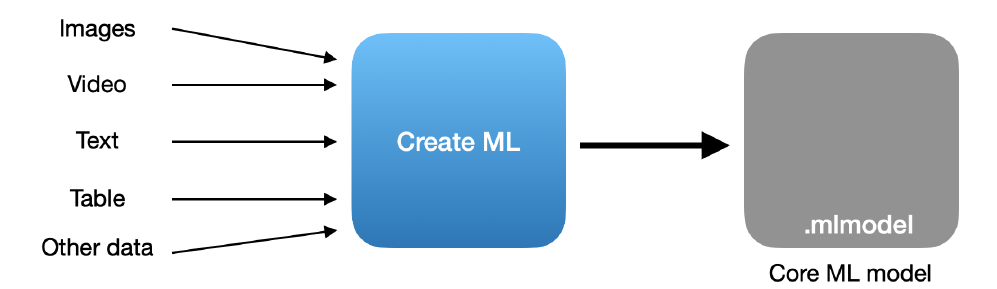
Figure 1. The data used by Create ML for model creation.